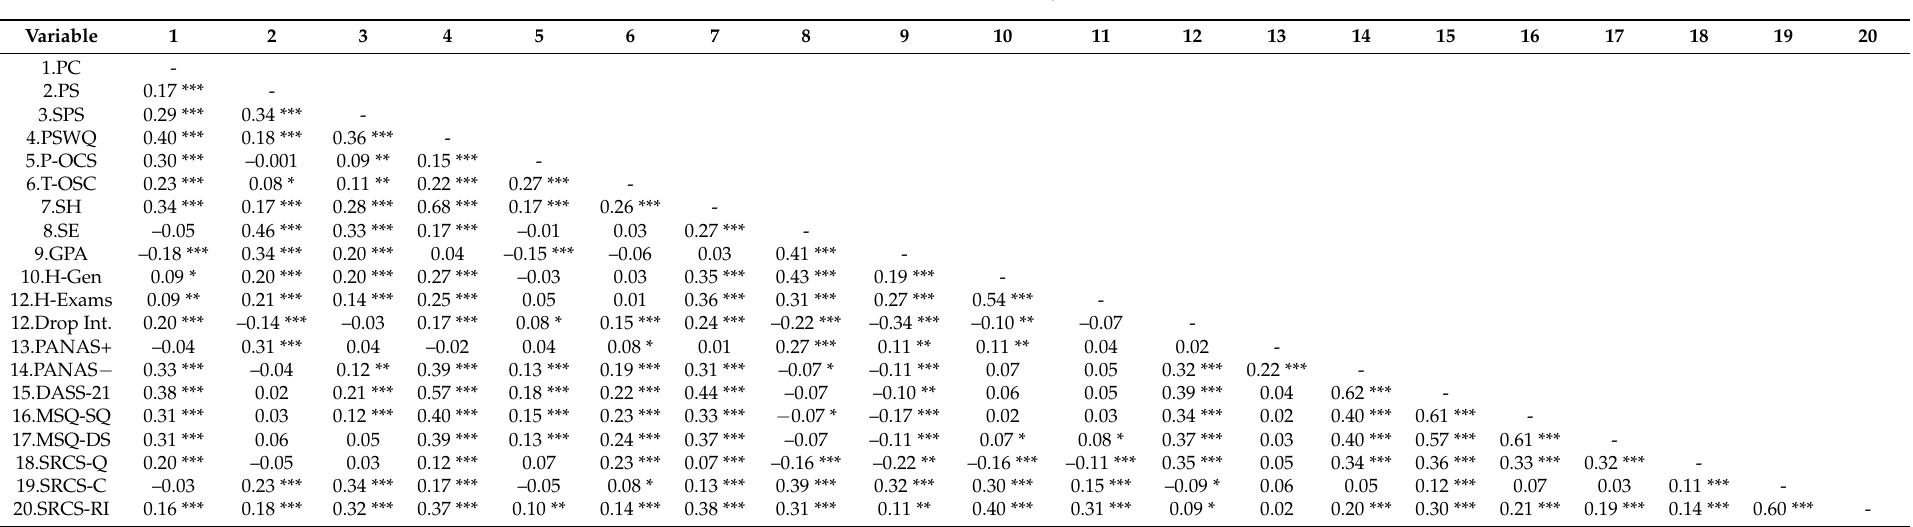
Table 2. Zero-order correlations for study variables ( n =